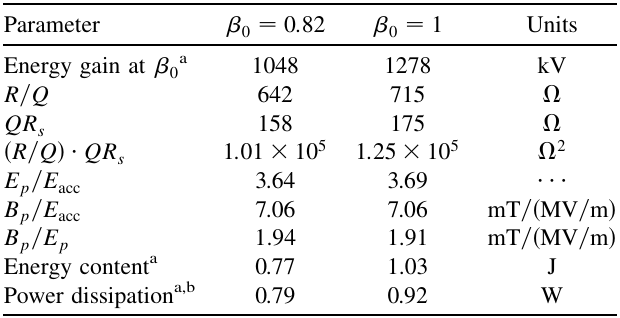
TABLE II. Radio-frequency properties, 352 MHz, (cid:1) 0 ¼ 0 : 82 and (cid:1) 0 ¼ 1 .